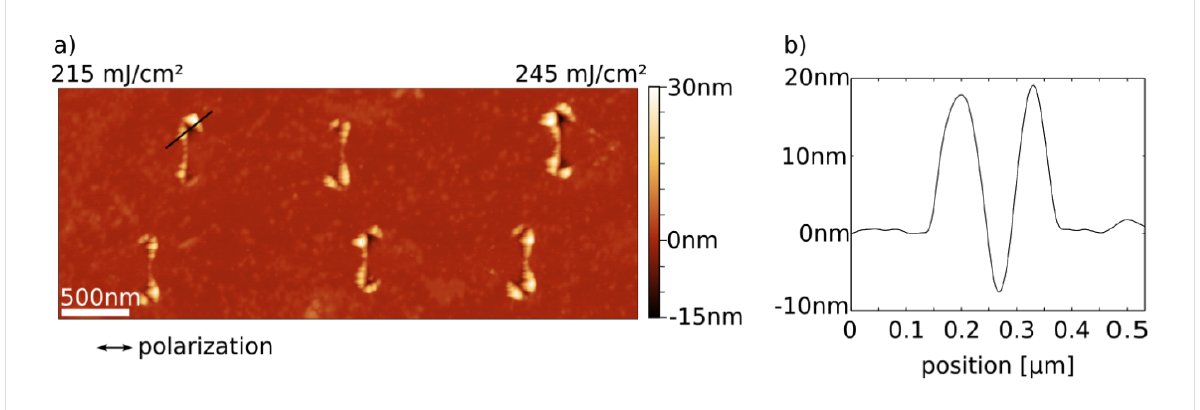
Figure 7: (a) AFM image of a Si surface with ablation holes, generated by irradiation of colloid lithography triangles with a single femtosecond laser pulse. (b) height profile of one of the holes taken along the black line in (a). The arrow indicates the polarization of the laser light. The incident inten- sity increases to the right from 215 to 245 mJ/cm 2 . Gold droplets resulting from sample preparation and ablation have been removed with aqua regia. Here, the volume of the material deposited in the rim appears to be distinctly larger than the volume of the crater hole. This is due to a change in com-